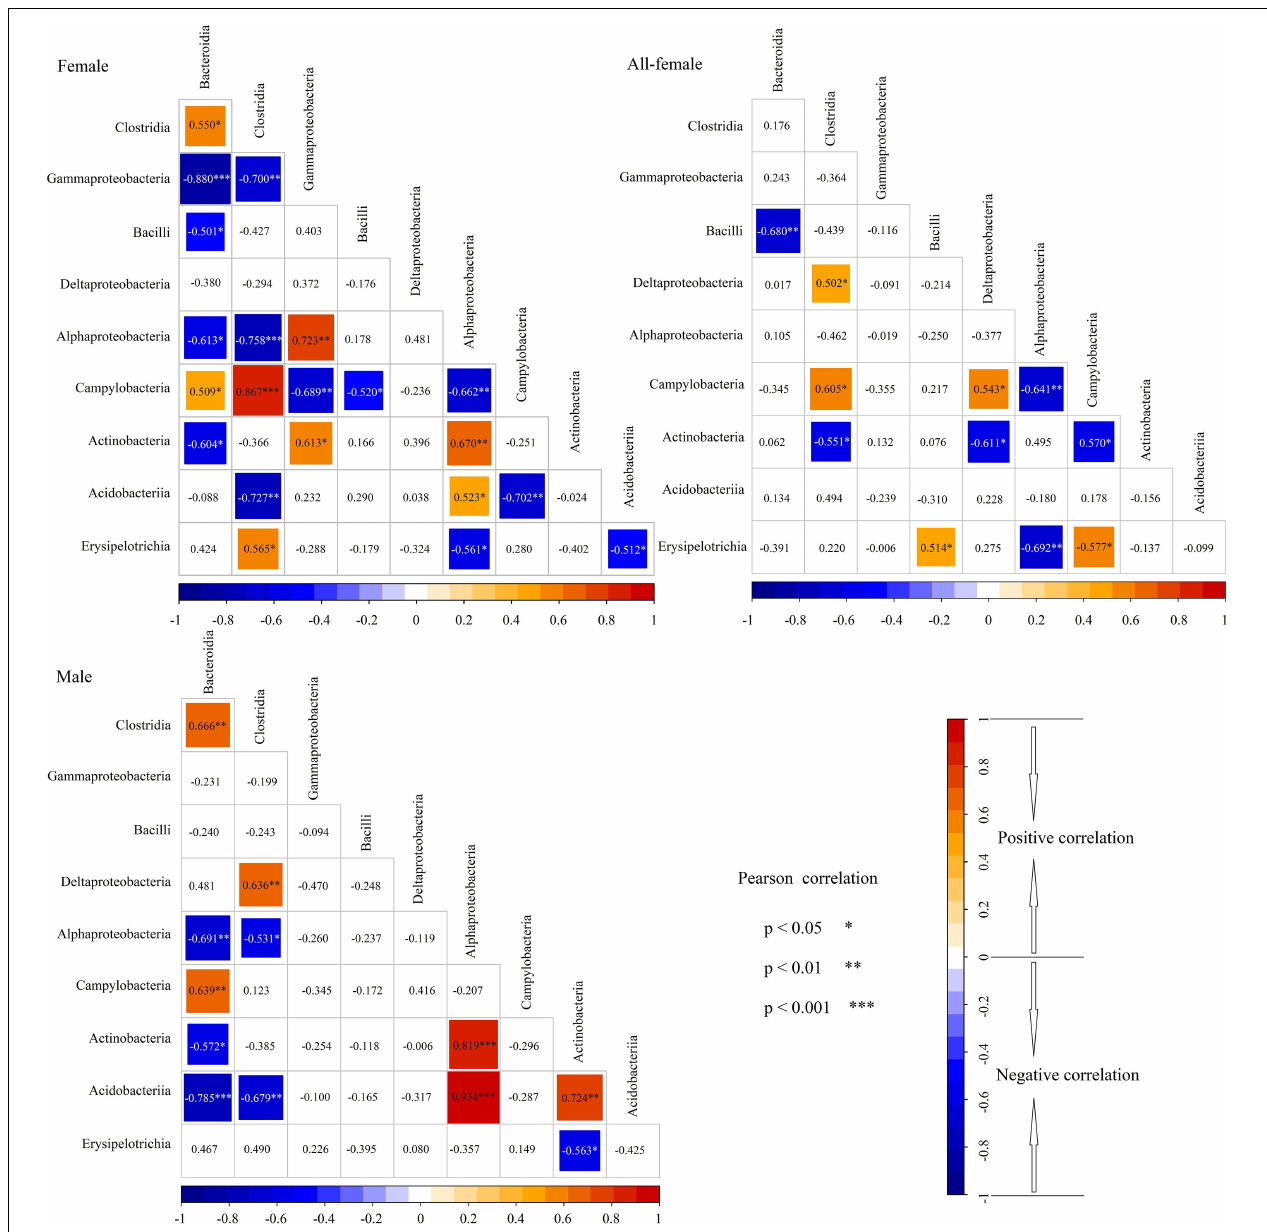
FIGURE 5 | Relationships between microbial communities in the intestinal microbiota of Nibea albiflora female, male, and all-female fish during an investigation of the composition of their intestinal microbiota. Female: CS and CW groups; Male: XS and XW groups; All-female fish: QS and QW groups. Red in the cells indicated a positive correlation, while bule indicated a negative correlation. * Difference indicated by a significant correlation with P < 0.05. ** Difference indicated by a significant correlation with P < 0.01. *** Difference indicated by a significant correlation with P < 0.001.